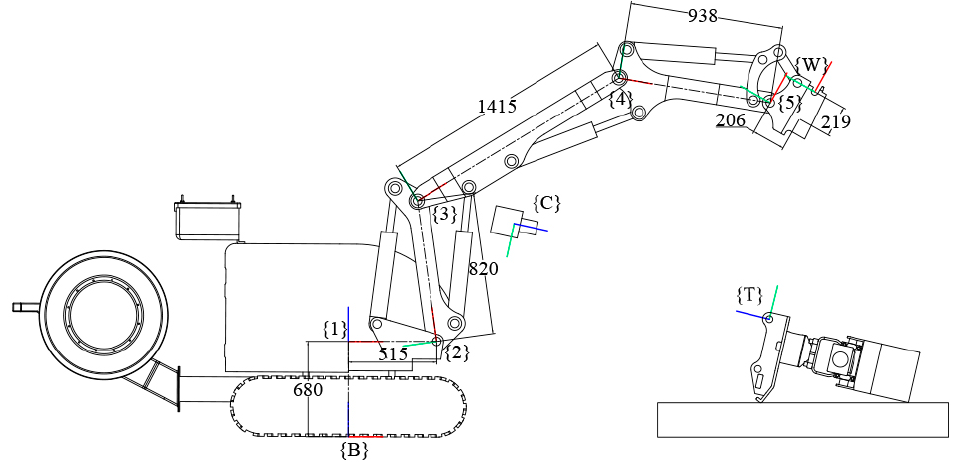
Figure 2. Coordinate frame of a BROKK 160 robot. {B} is the robot’s base coordinate frame, {W} is the quick-hitch dock spot coordinate frame, {C} is the camera coordinate frame, and {T} is the attachment dock spot coordinate frame (the red axis is the X-axis, the green axis is the Y-axis, and the blue axis is the Z-axis).